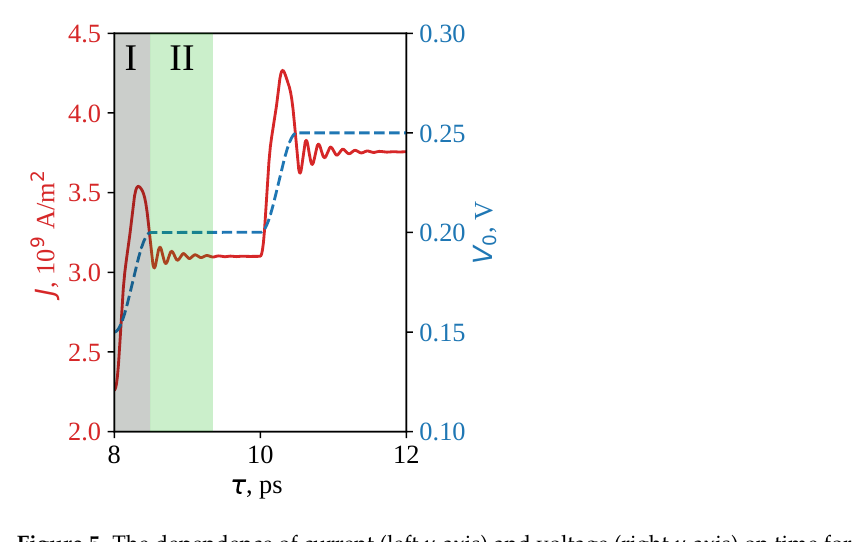
Figure 5. The dependence of current (left y -axis) and voltage (right y -axis) on time for Nanostructure #1 at L SE = 4